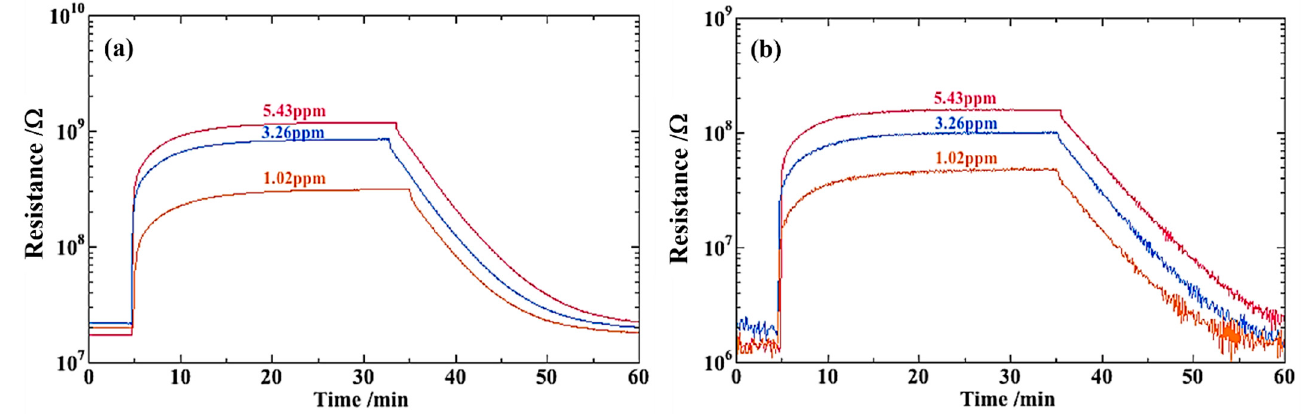
Figure 7. Transient response curves of the sensors with sample A ( a ) and B ( b ) in ethanol at 320